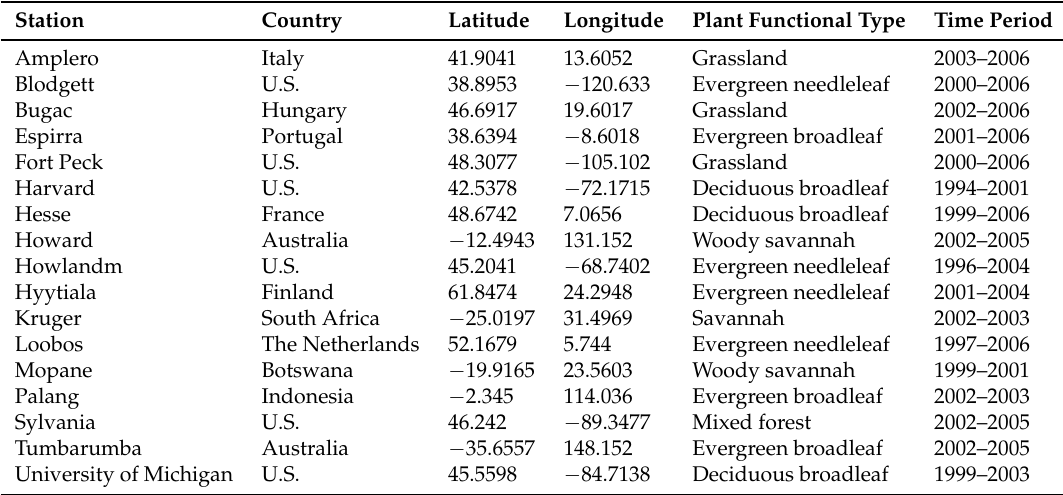
Table 1. FLUXNET tower flux stations used in this